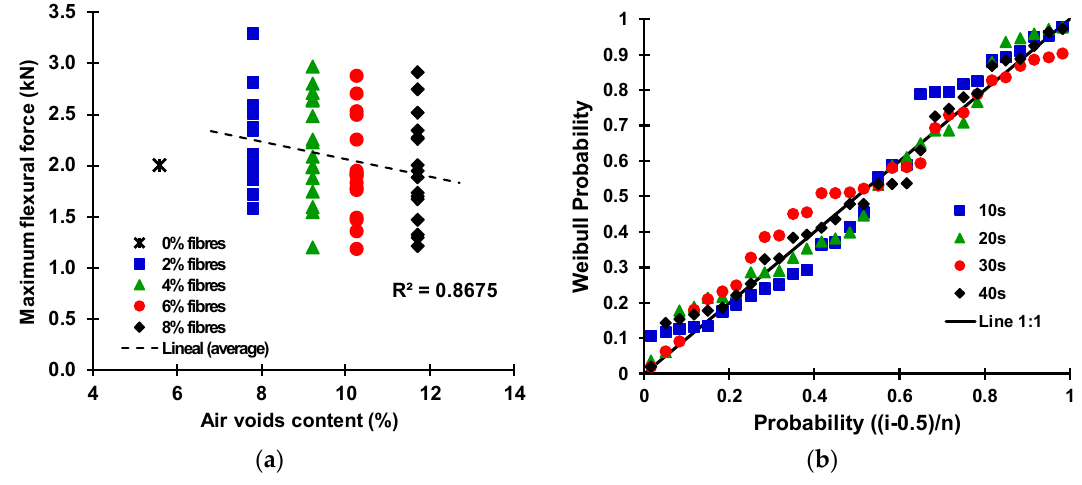
Figure 8. ( a ) Maximum flexural force versus the air void content of asphalt mixtures with different fibres content; ( b ) Weibull probability-probability plot for all Cycle Reduction Ratio data.